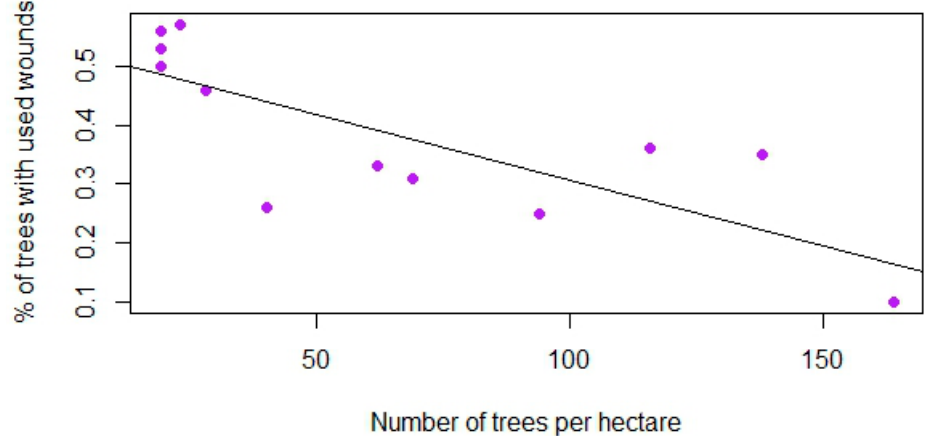
Figure 9. Correlation showing the relationship between the tree density and the percentage of trees with used wounds from the total wounded trees in 12 plots ( p -value =